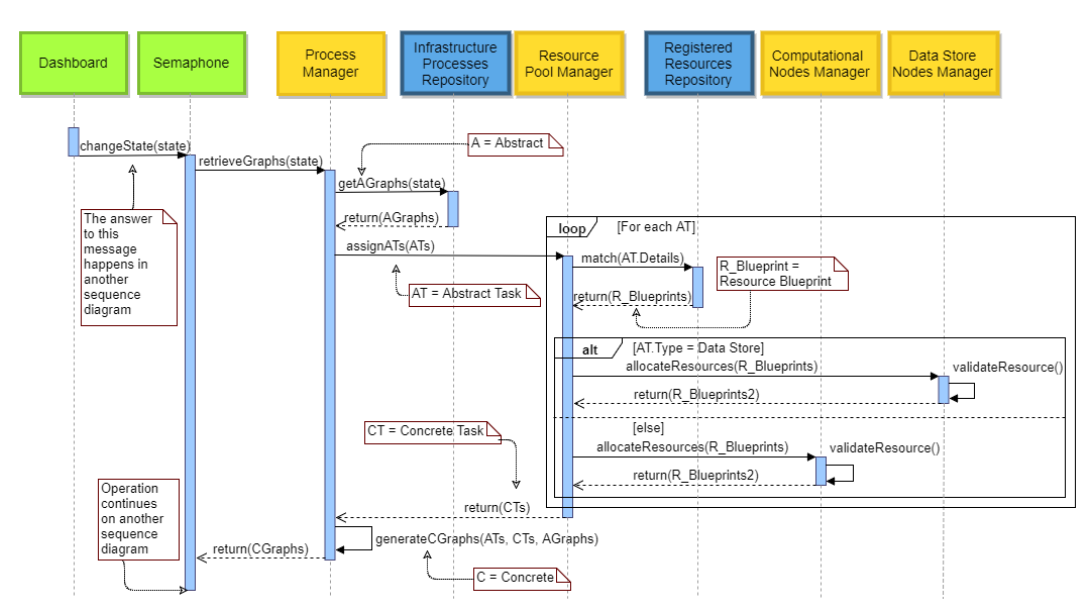
Figure 14. Resource